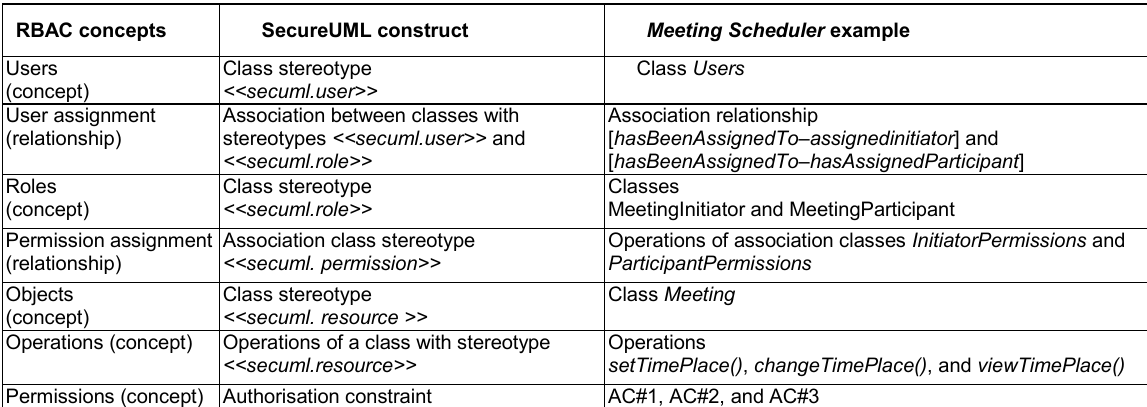
Table 1. Correspondence between RBAC concepts and SecureUML